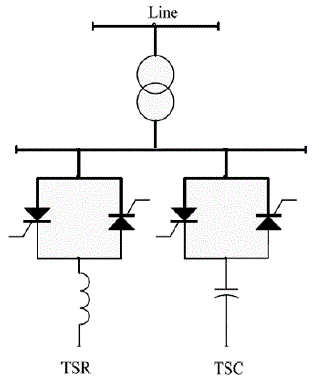
Figure 1. Block diagram of static VAR compensator